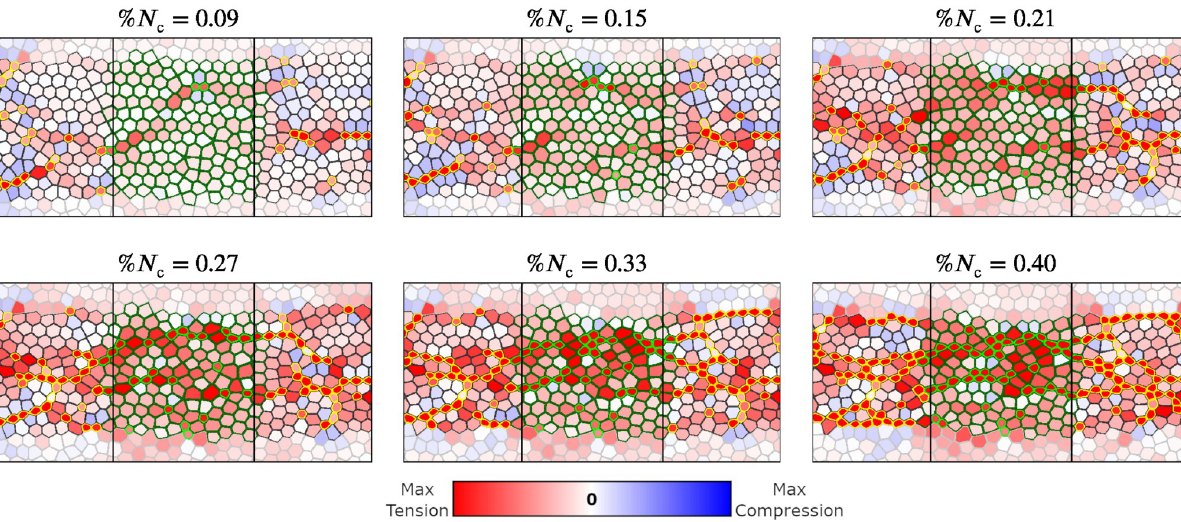
Fig 11. The mechanism of constriction chain penetration into the disrupted zone in a system with tensile feedback. Time-lapse images for the AGF system with a band of cells whose constriction probability is reduced by 80% ( α r = 0.2). Color convention per Fig 10. Top frames show the initial formation of precursor tensile-stress chains crossing the affected region. Due to tensile feedback the constriction probability is elevated along these precursor chains. Thus cellular constrictions follow, resulting in formation of constriction chains crossing the disrupted zone (bottom frames).